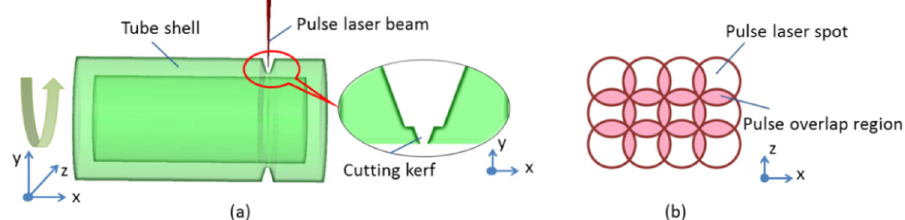
Figure 4. Configuration of the femtosecond pulse laser process: ( a ) schematic diagram of laser beam action; ( b ) schematic description of the scanning pattern drawn.